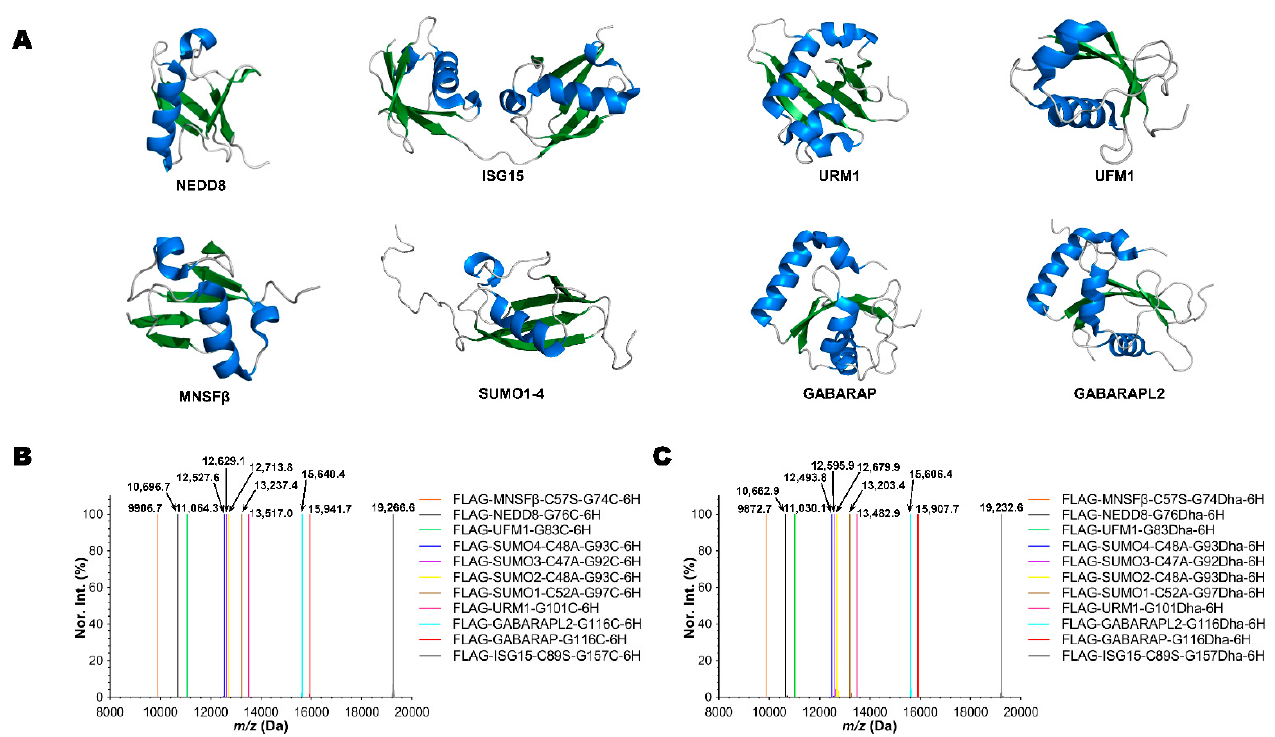
Figure 3. The synthesis of FLAG-Ubl-GxDha-6H probes by NTCB-triggered Dha formation from cysteine. ( A ) The structures of different Ubls used. ( B ) The deconvoluted and integrated ESI-MS spectra of 11 recombinant FLAG-Ubl-GxC-6H proteins. ( C ) The deconvoluted and integrated ESI-MS spectra of 11 synthesized FLAG-Ubl-Dha-6H probes. All detected molecular weights agreed well with theoretical values in a deviation range of ±0.4 Da.